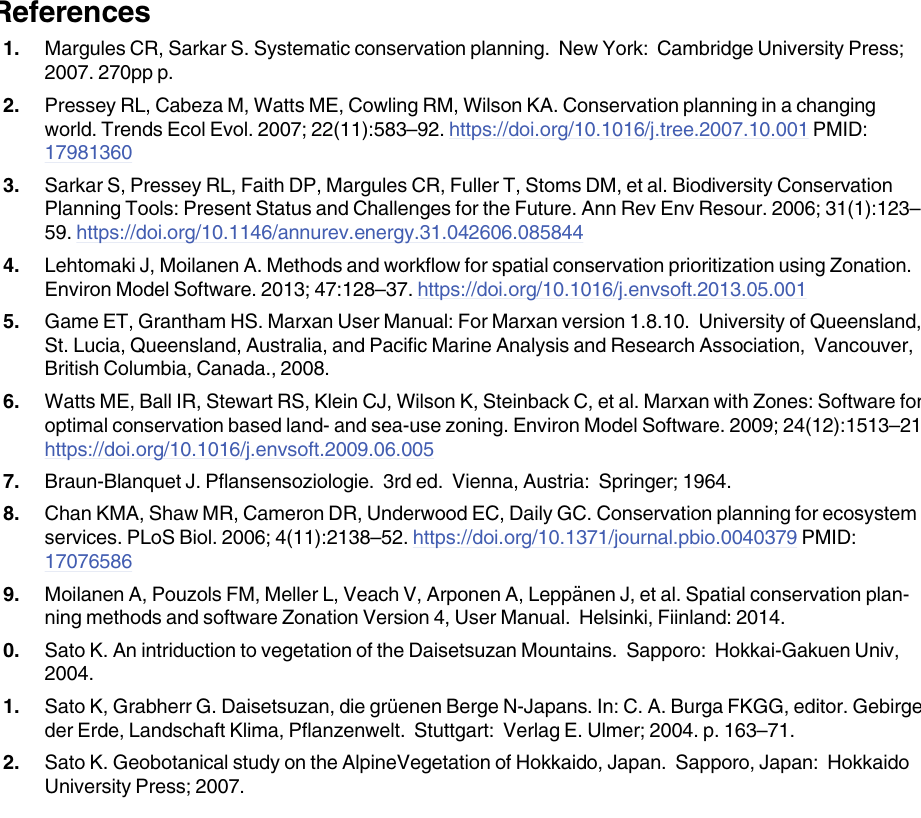
S1 Fig. Site-selection pattern for each run for difference parameter settings for SecSel.